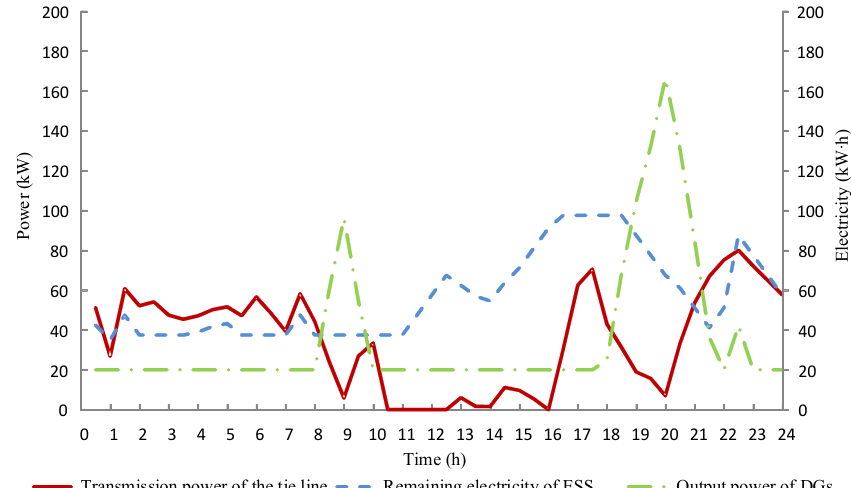
Figure 12. Realized operation results under Strategy B.